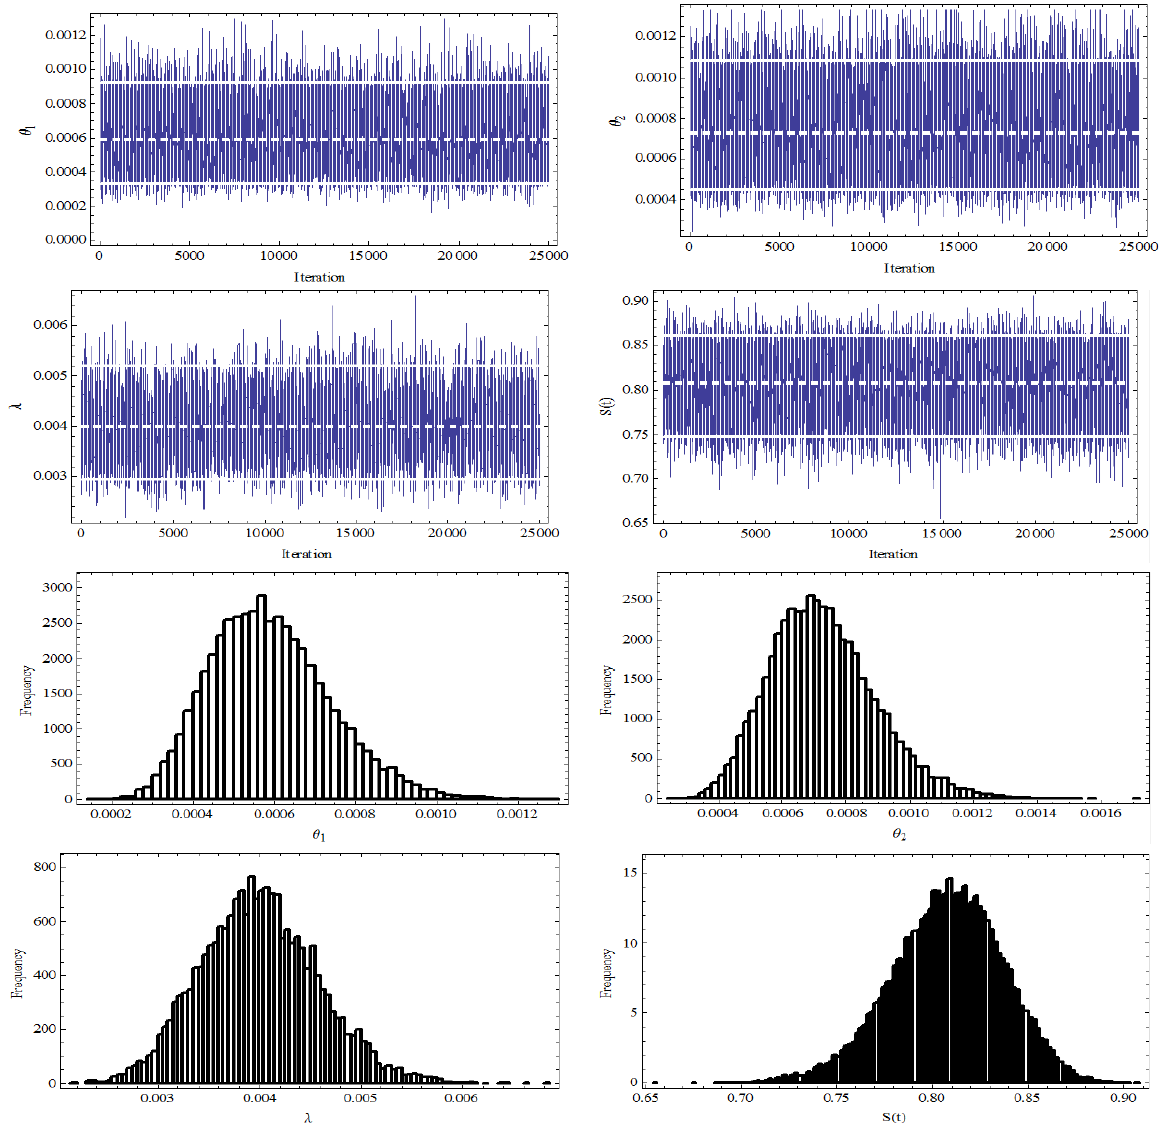
Figure 8. MCMC trace plot (first row) and Histogram (second row) of θ 1 , θ 2 λ , and S ( t ) for Xia et al. Fig. 8: MCMC trace plot ((cid:133)rst row) and Histogram (second row) of (cid:18) 1 ; (cid:18) 2 (cid:21) , and S ( t ) for Xia et al. (2009) data. Dashed lines ( ... ) (2009) data. Dashed lines ( ...) represent the posterior means and soled lines (—) represent lower, represent the posterior means and soled lines ((cid:151) ) represent lower, and upper bounds 95% probability interval. and upper bounds 95% probability